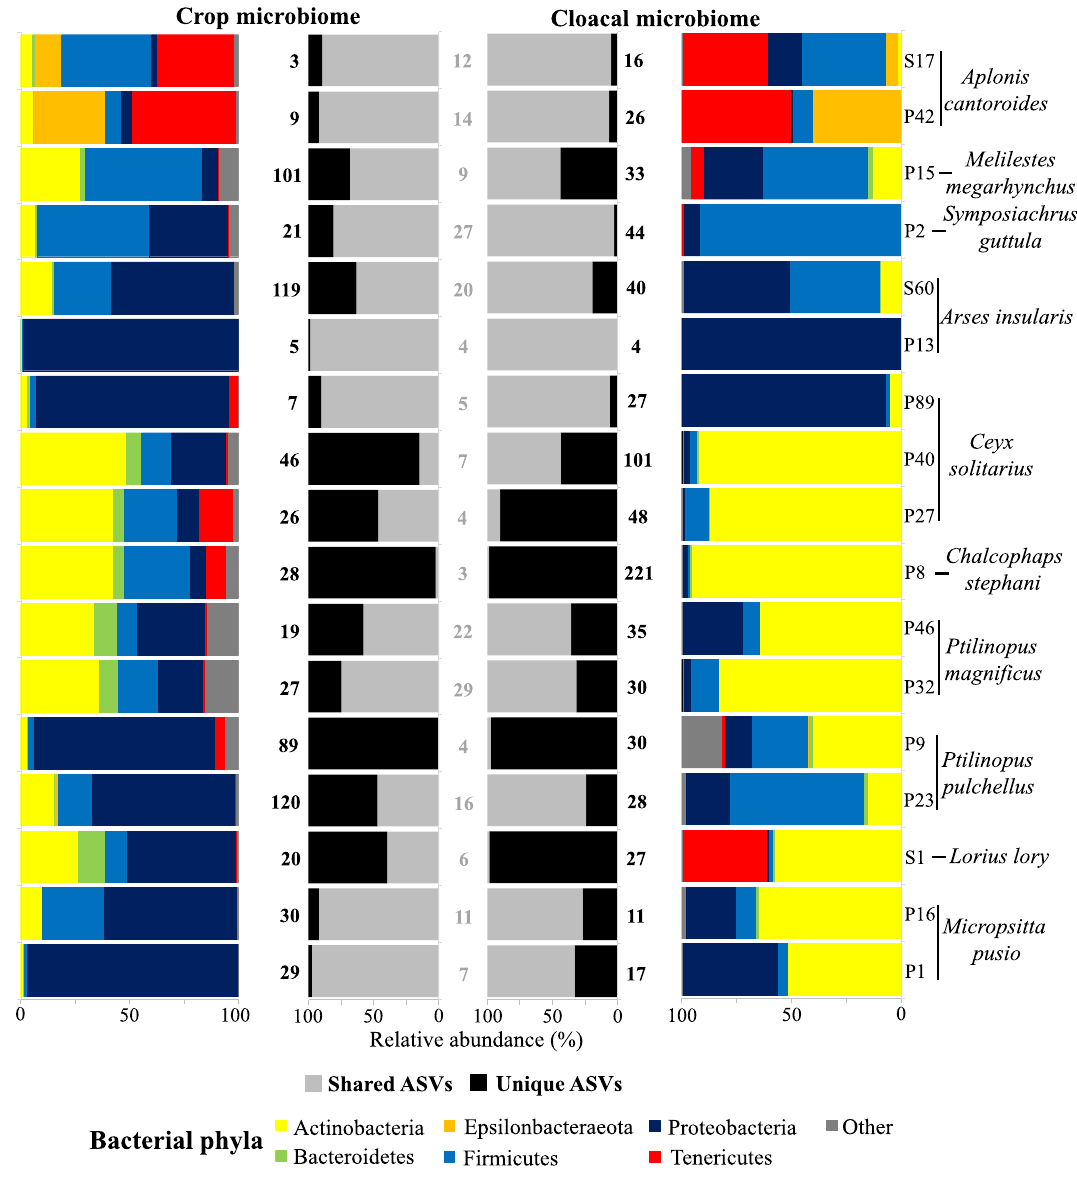
Figure 6. Crop and cloacal microbiomes share a large proportion of abundant bacterial ASVs. The far left and far right panels show the relative abundance of bacterial phyla in the crop and the cloacal microbiomes of the same individual. The two panels in the middle show the proportion of bacterial sequences (relative abundance) belonging to the shared and unique ASVs in the two regions. The number of unique ASVs are shown in black and shared ASVs are shown in